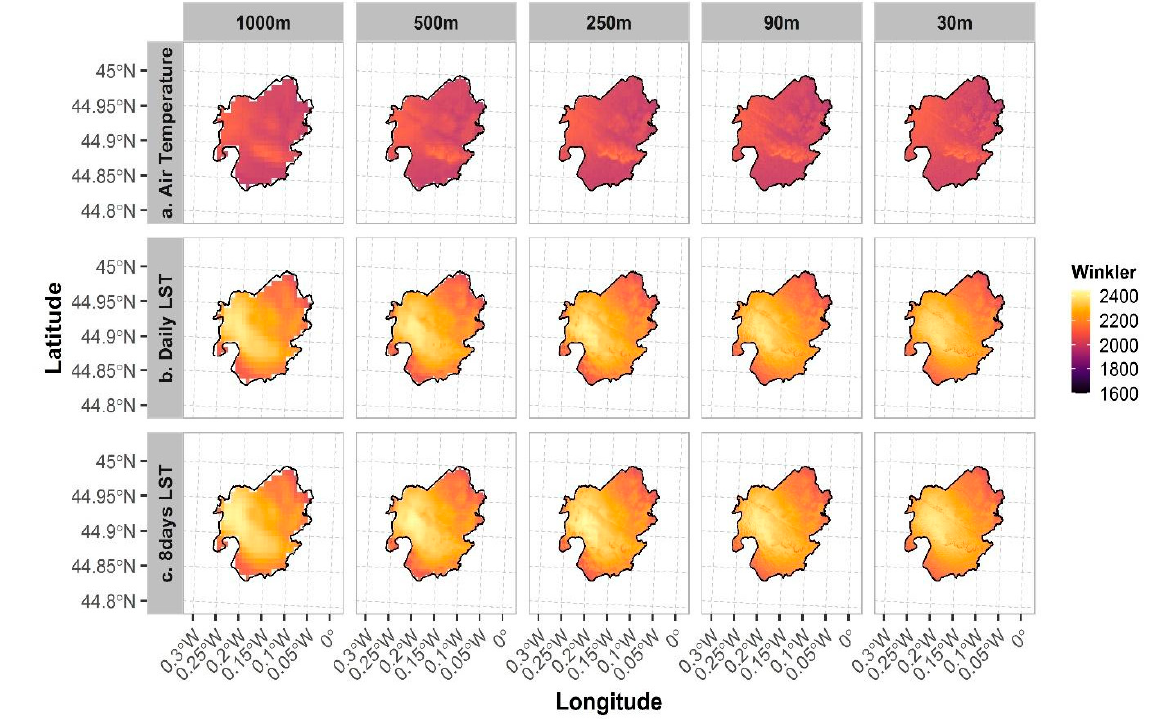
Figure 7. Spatial distribution of the Winkler index averaged from 2012–2018 and gridded at different spatial resolutions using ( a ) predicted air temperature, ( b ) downscaled daily land surface temperature (LST) (M*D11A1) and ( c ) downscaled 8-day LST (M*D11A2).